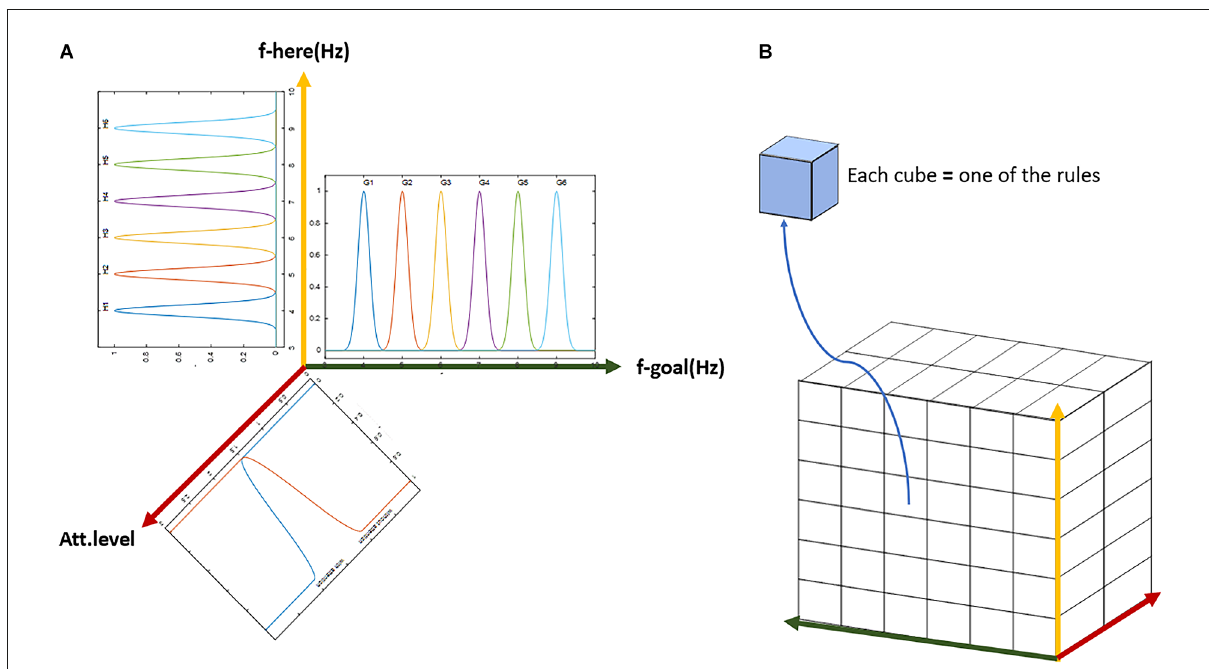
FIGURE11 The general scheme of the lookup table based fuzzy system. (A) Demonstration of the three-dimensional input with membership functions defined on each dimension. (B) The three-dimensional table of rules with complete coverage of the input space. Each block (cube in the figure) represents one rule. The whole set of rules cover all possible options of input and output over the assumed cognitive map with six landmarks and two attention states (with or without).